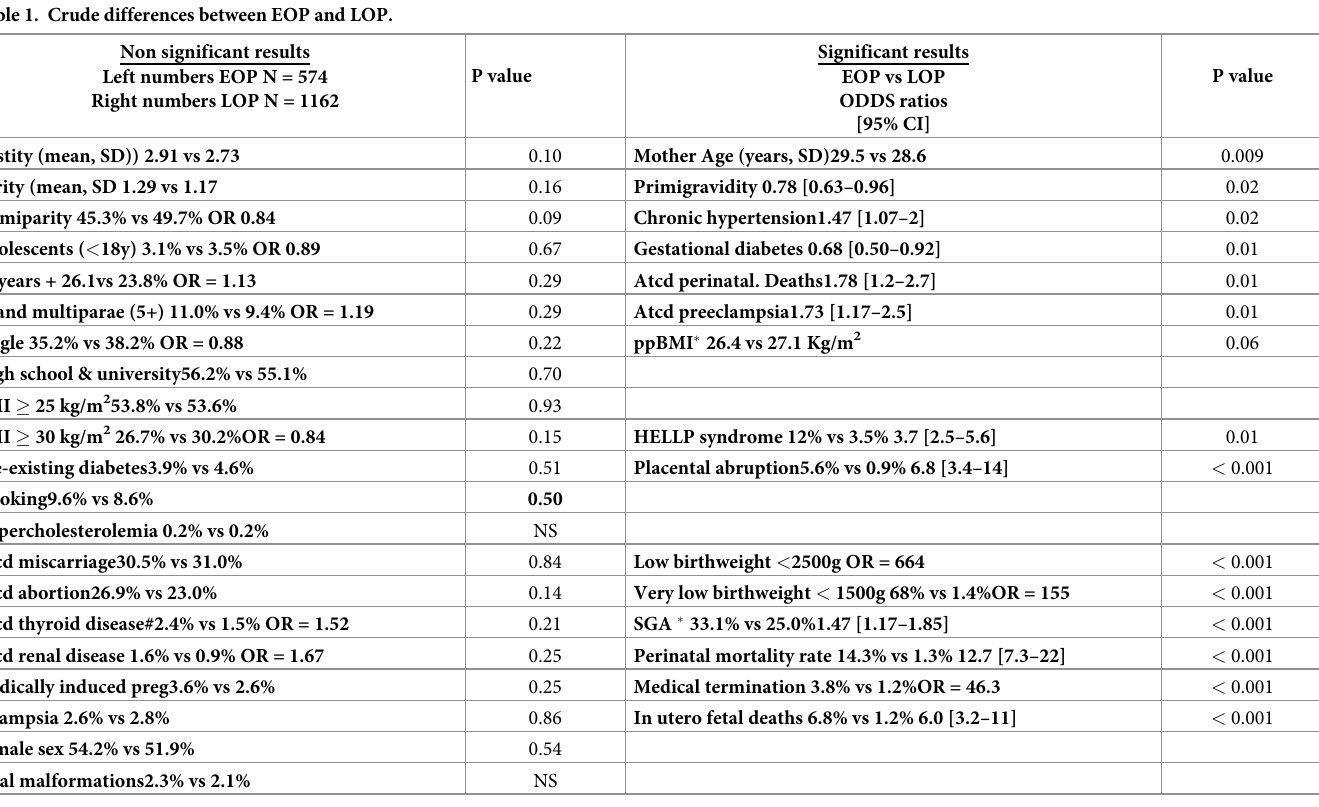
Table 1. Crude differences between EOP and LOP.